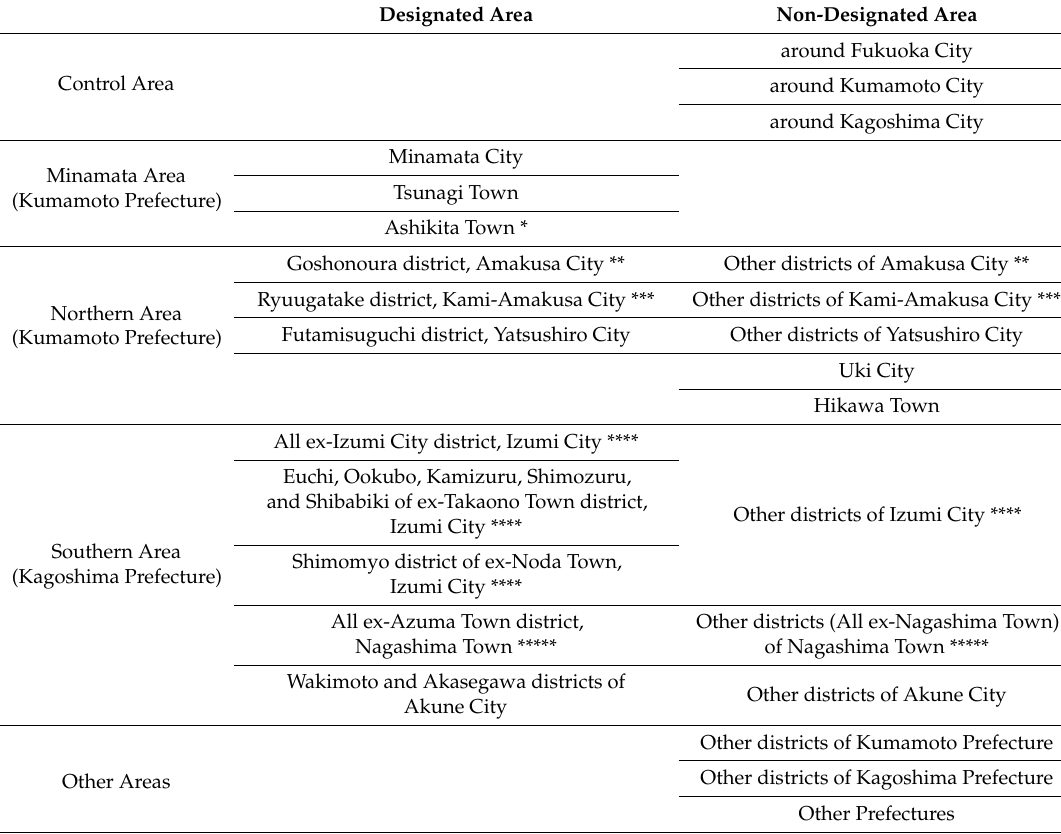
Table 1. Surveyed area and designated